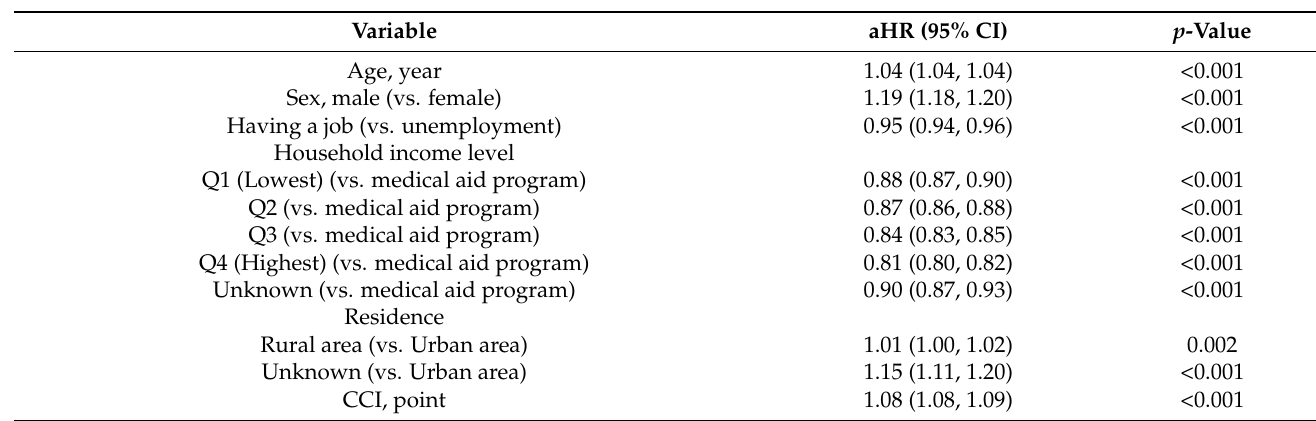
Table 4. Multivariable Cox regression model for 1-year mortality among patients admitted to the ICU in South Korea from 2010 to